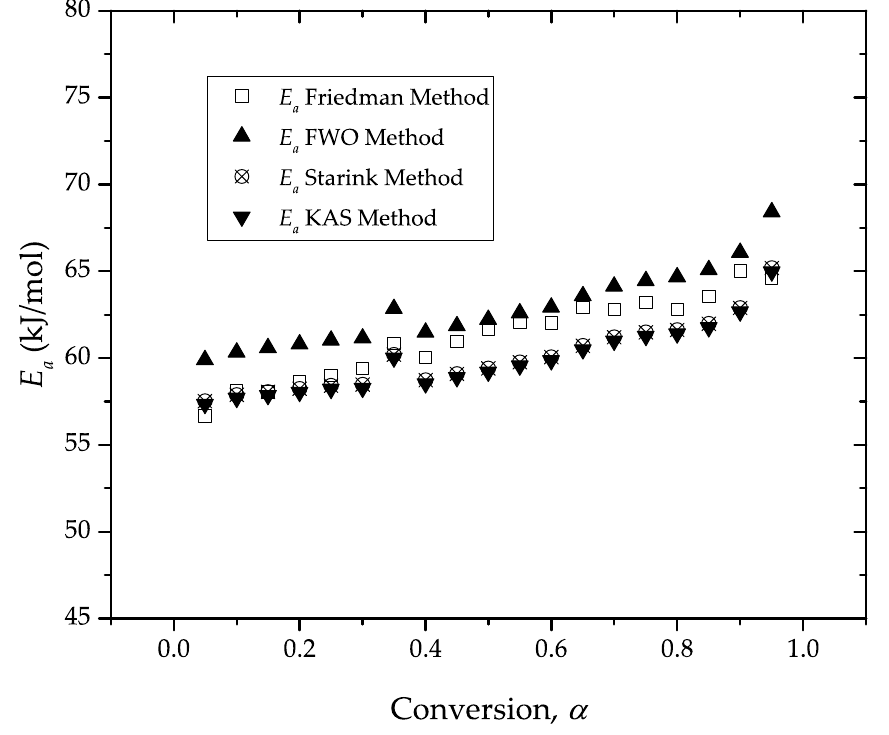
Figure 8. Variation of the apparent activation energy, E a , as a function of function of conversion α , corresponding to the crosslinking of a partially bio ‐ based epoxy resin for different heating rates.